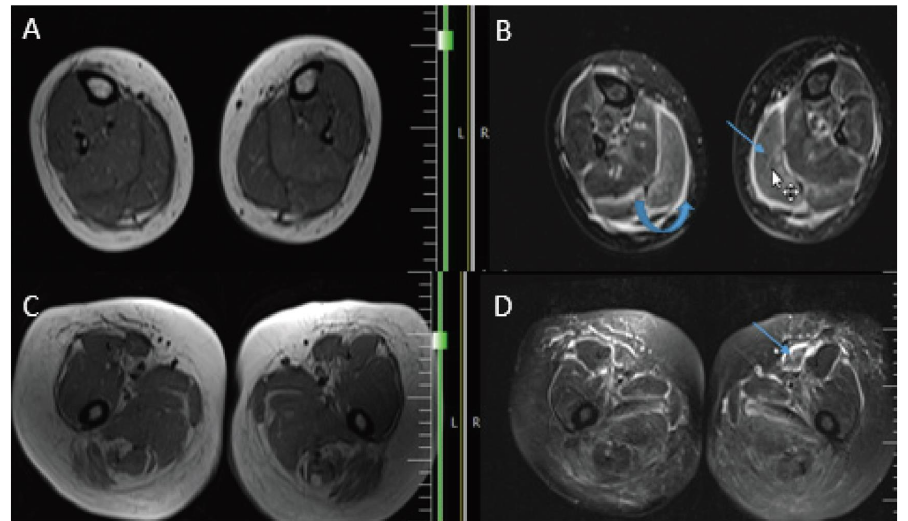
Figure 2: (a and b): MRI of both legs; T1W (a) and fuid sensitive fat sat (b) sequences; perimuscular and fascial edema (curved arrow) and intra muscular edema (arrow) within gastrocnemius muscles; (c and d): MRI of both thighs T1W (c) and fuid sensitive fat sat (d) sequences; perimuscular and fascial edema (arrow) more in anterior